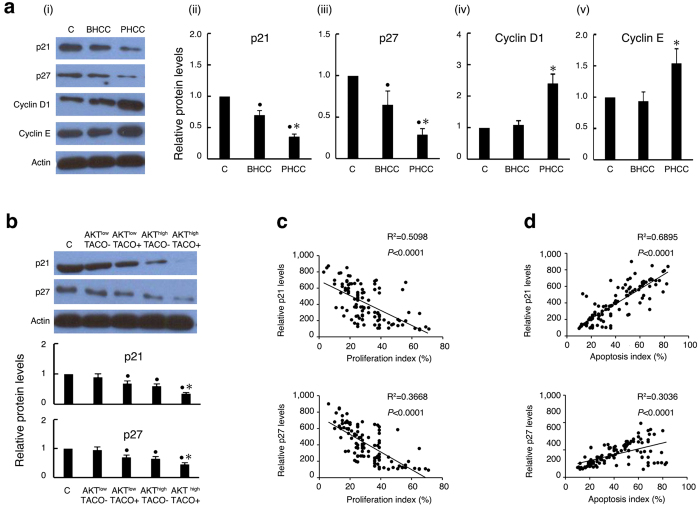
Correlation of pAKT and TACO with cell cycle regulators and cell viability in human HCC.(a) Expression of cell cycle regulatory genes in human HCC tissues. Representative immunoblotting of cell cycle regulators (i). Relative protein expressions of p21(ii), p27 (iii), Cyclin D1 (iv), and Cyclin E (v), and levels in their surrounding non-HCC livers as control (normalized as 1). •P < 0.05 compared with control; *P < 0.05: PHCC vs. BHCC. (b) Representative immunoblotting of p21 and p27 in different HCC subtypes (Upper), and their relative protein levels (Lower). •P < 0.05: compared with control; *P < 0.05: HCC with TACO+/AKThigh vs. TACO−/AKTlow or TACO+/AKTlow or TACO−/AKThigh. Correlation of p21 and p27 with the proliferation index (c) and apoptosis index (d). The proliferation and apoptotic indices of HCC were measured based on the number of Ki67-positive and apoptotic cells, respectively, and are expressed as a percentage of total hepatocytes.